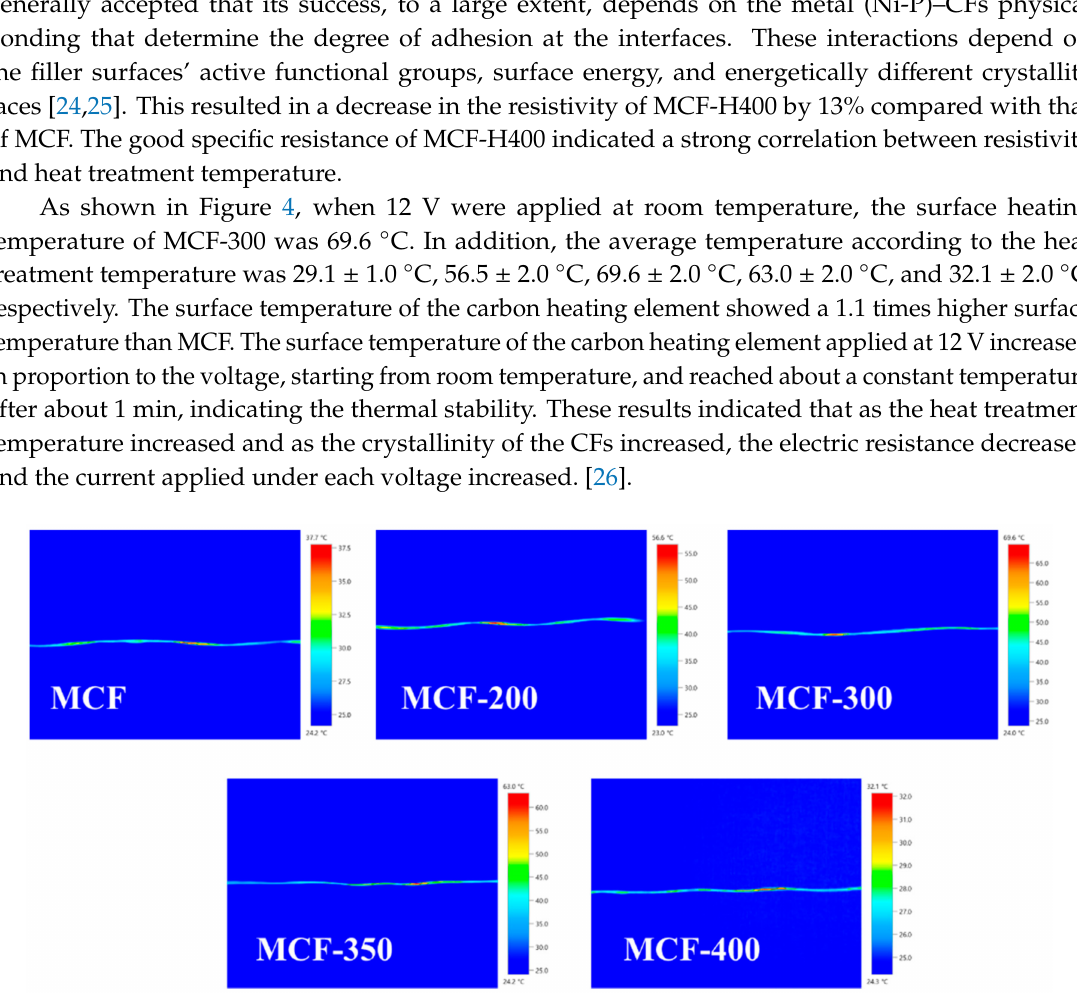
Figure 4. Thermo-graphic camera images of MCF as a function of heat treatment